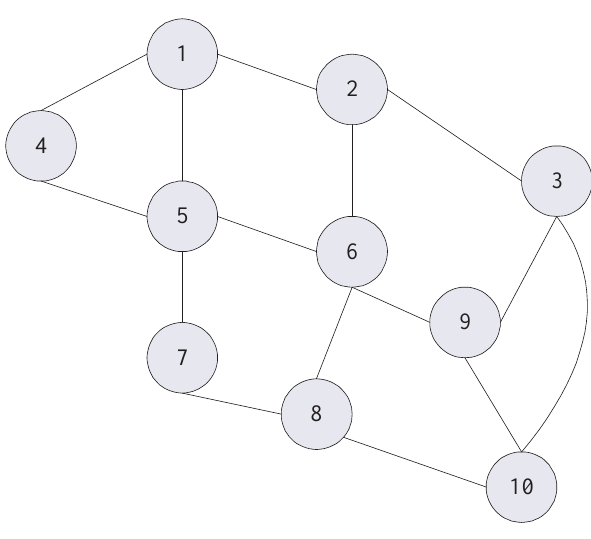
Figure 7. Topology of cluster heads.